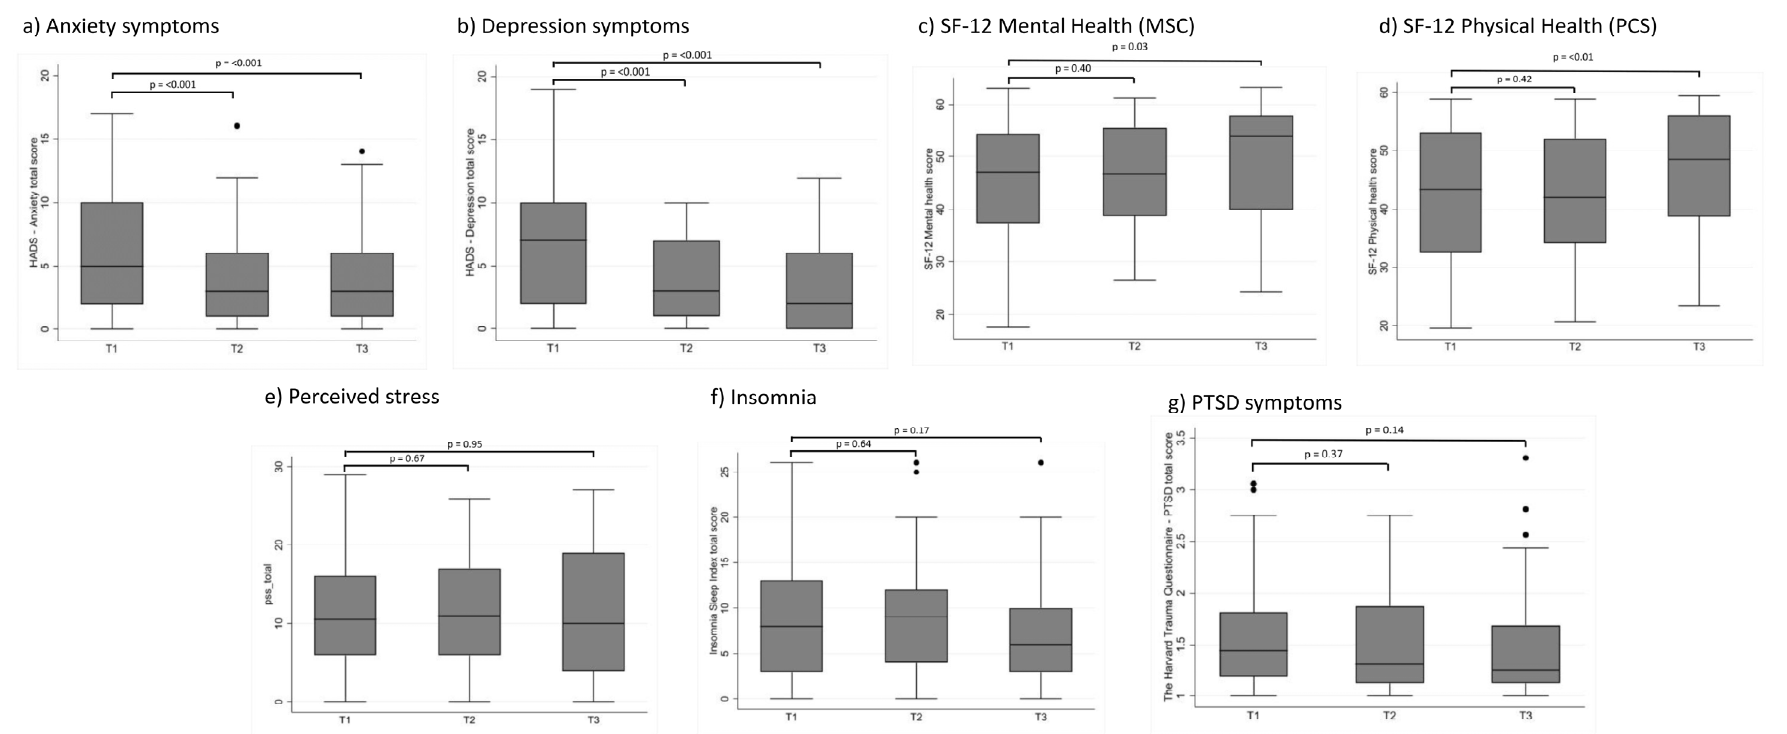
Figure 1. Psychological distress outcomes among hospitalized COVID-19 patients at admission (T1) and one month (T2) and three months (T3) after discharge.